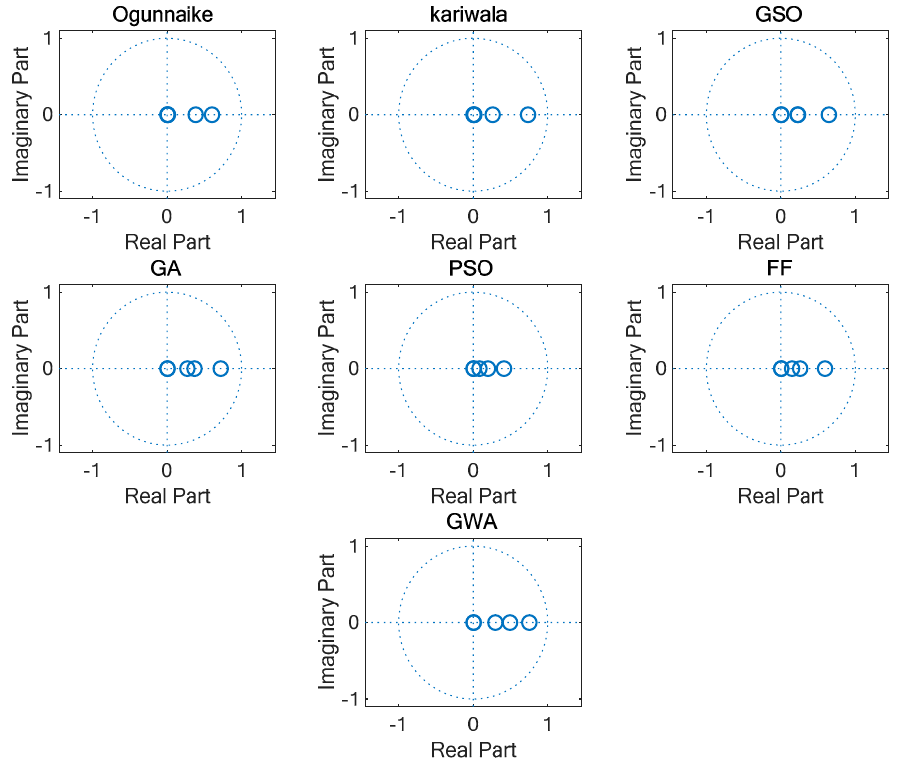
Algorithms 2019 , 12 , x FOR PEER REVIEW Figure 22. Example 2: z -plane plot for the roots of the characteristic equation. Table 14. Example 2: Jury’s stability test for pressure control ( c n = 1.5929 × 10 7 and θ Ref = 0.3295).